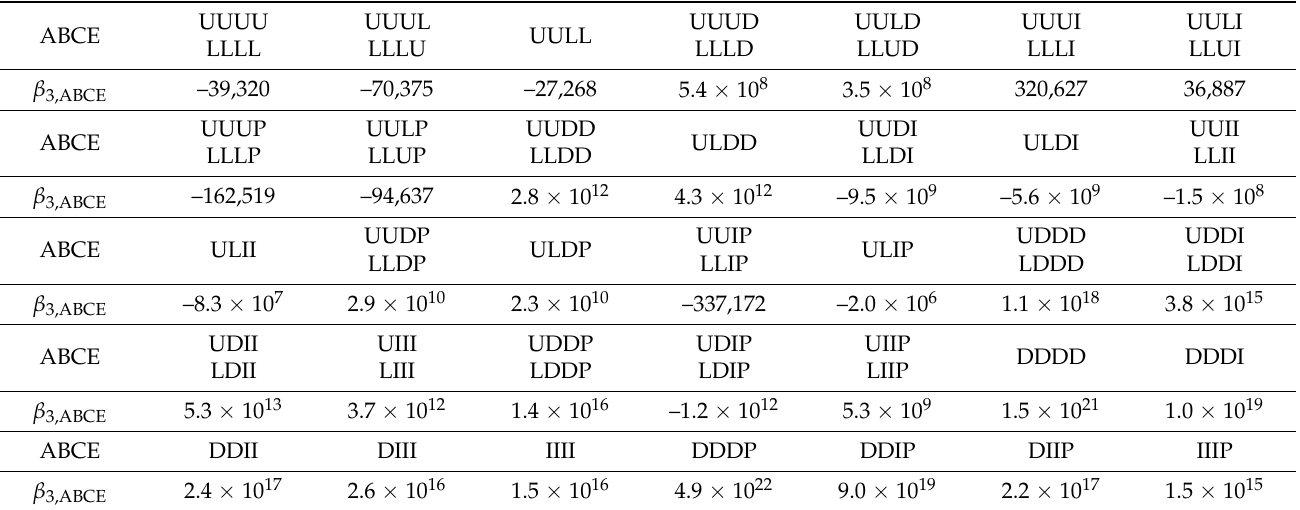
Table 3. Values of integrals β 3,ABCE for different types of interacting particles. The values are in the units of nm 6